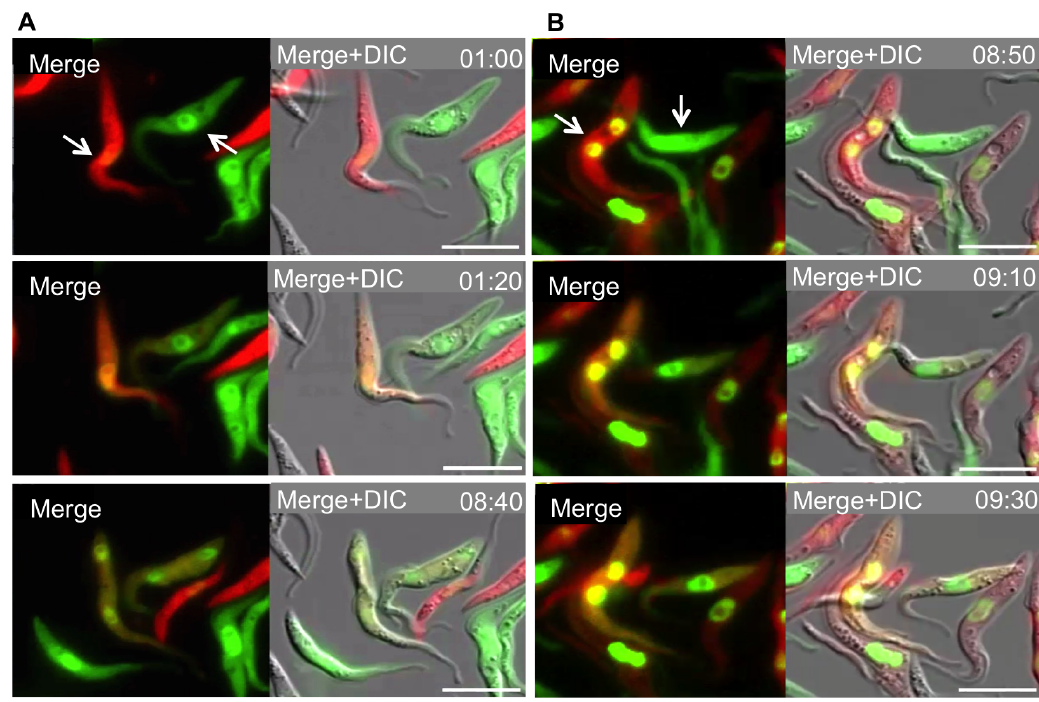
Figure 2. Trypanosomes exchange proteins but not DNA in a contact-dependent manner. Still images from time-lapse fluorescent microscopy of a mixed culture of wild type trypanosomes expressing Histone2B-GFP/cytosolic DsRED or Histone2B-GFP/cytosolic GFP. The time interval between images is indicated at the right corner of the image; the scale bar indicates 10μm; arrows indicate interacting cells. A : First image taken after one hour, the cells are clearly separate and only positive for one fluorescent protein in the cytoplasm. Second image 20 minutes later (1:20), cells are in contact and have become positive for DsRED and GFP. Third image, 7 hours and 20 minutes later (8:40), the cells have separated again. (Video 1) B : First image taken after 8 hours 50 minutes, cells are only positive for one fluorescent protein in the cytoplasm. Second image, cells have become double-positive (09:10). Third image, 20 minutes later the cells have separated again (09:30). (Video